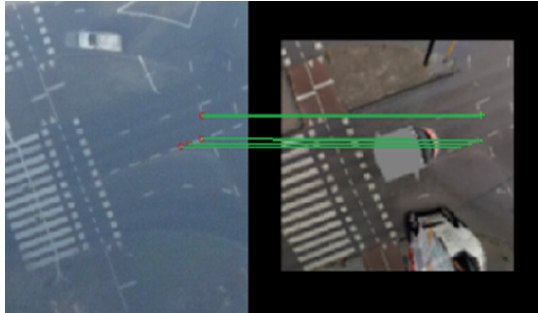
Figure 7. Förstner Cross-Correlation matching result of 2 nd tile